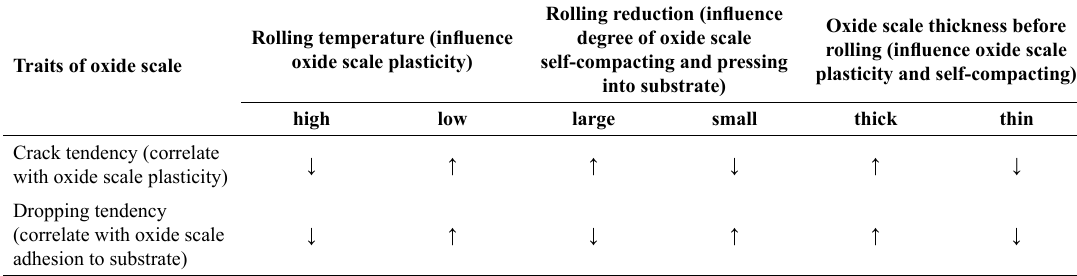
Table 3. The influence of rolling parameters on the traits of oxide scales